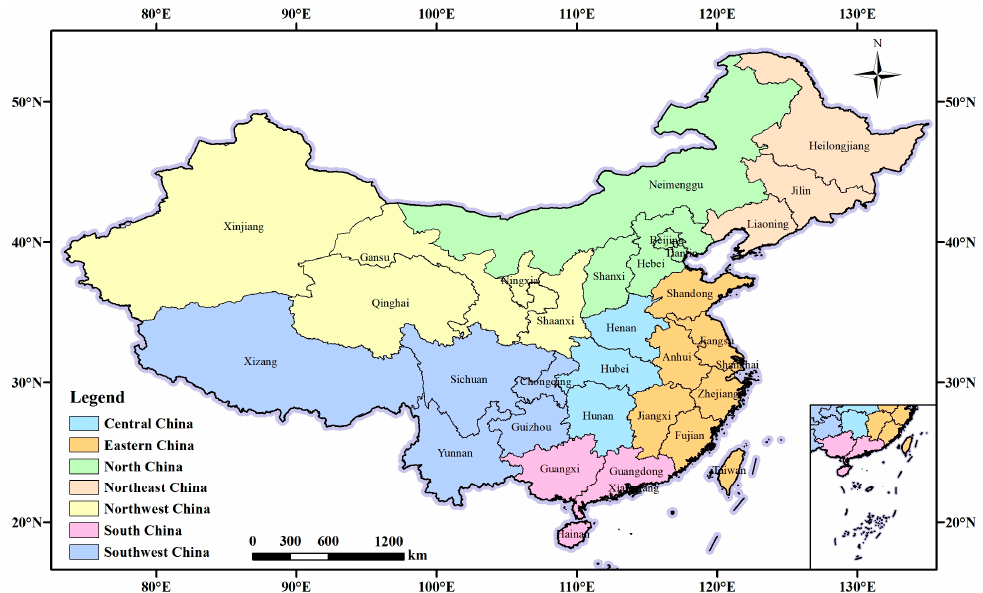
Figure 13. Map of Geographical Divisions of China.